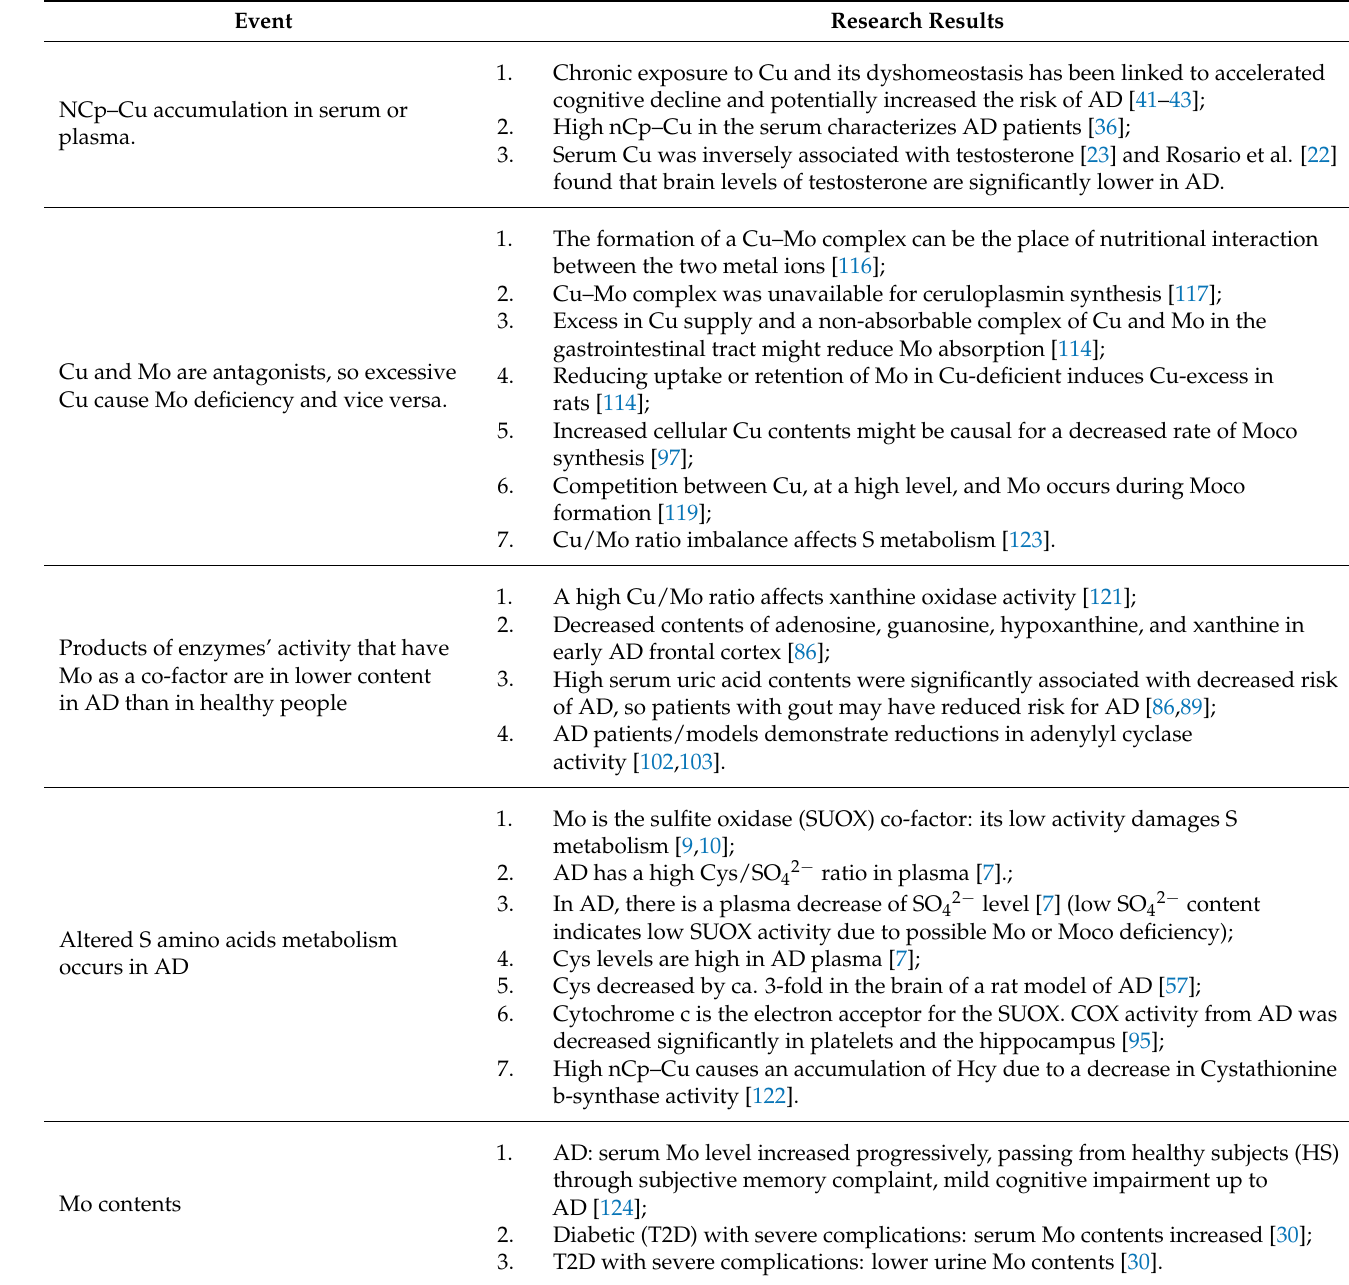
Table 2. Possible links between Alzheimer’s Disease (AD) and Mo deficiency or/and Cu–Mo–S altered